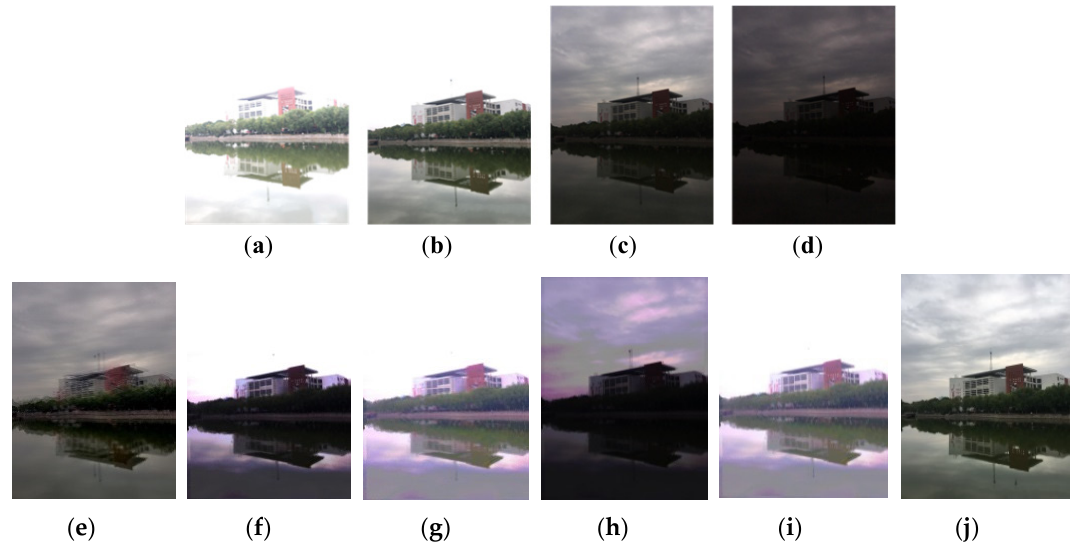
Figure 11. The sequence of exposure for the image and fusion results of the test. ( a )–( d ) The image sequence. ( e ) Fused image by JPEG directly. ( f ) Fused image using the method of Drago [28]. ( g ) Fused image using the method of Durand [27]. ( h ) Fused image using the method of Reinhard [25]. ( i ) Fused image using the method of Mantiuk [26]. ( j ) Fused image using our proposed method.